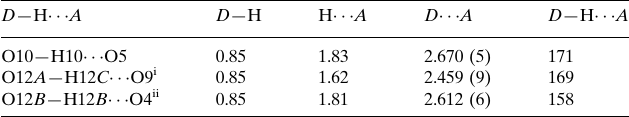
Hydrogen-bond geometry (A˚ , (cid:3)